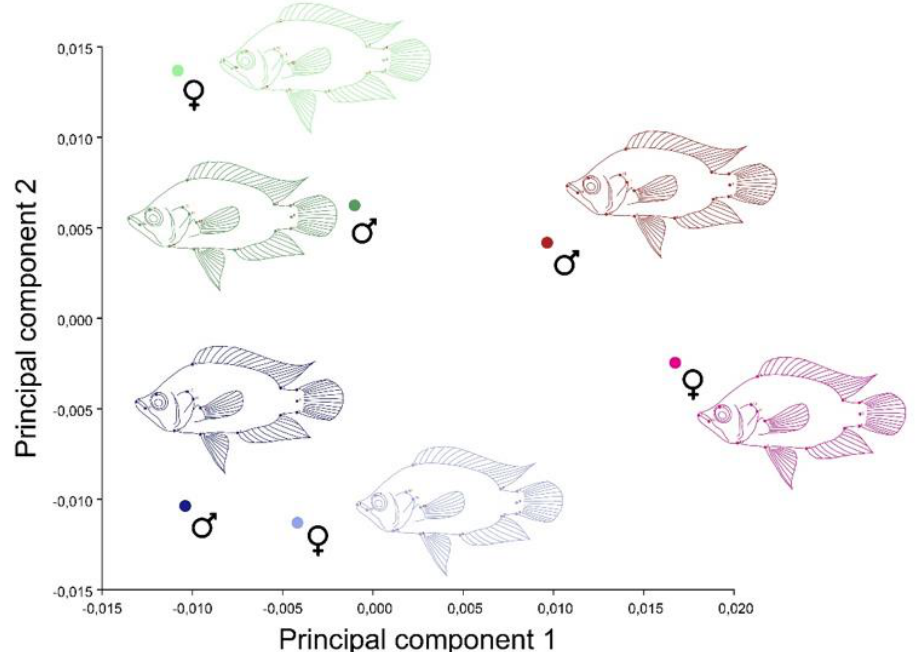
Figure 4. Average principal component analysis of Caquetaia kraussi representing sexual shape dimorphism among localities. Pink: female UEP1; red: male UEP1; light green: female UEP2; dark green: male UEP2; light blue: female UEP4; and dark blue: male UEP4.